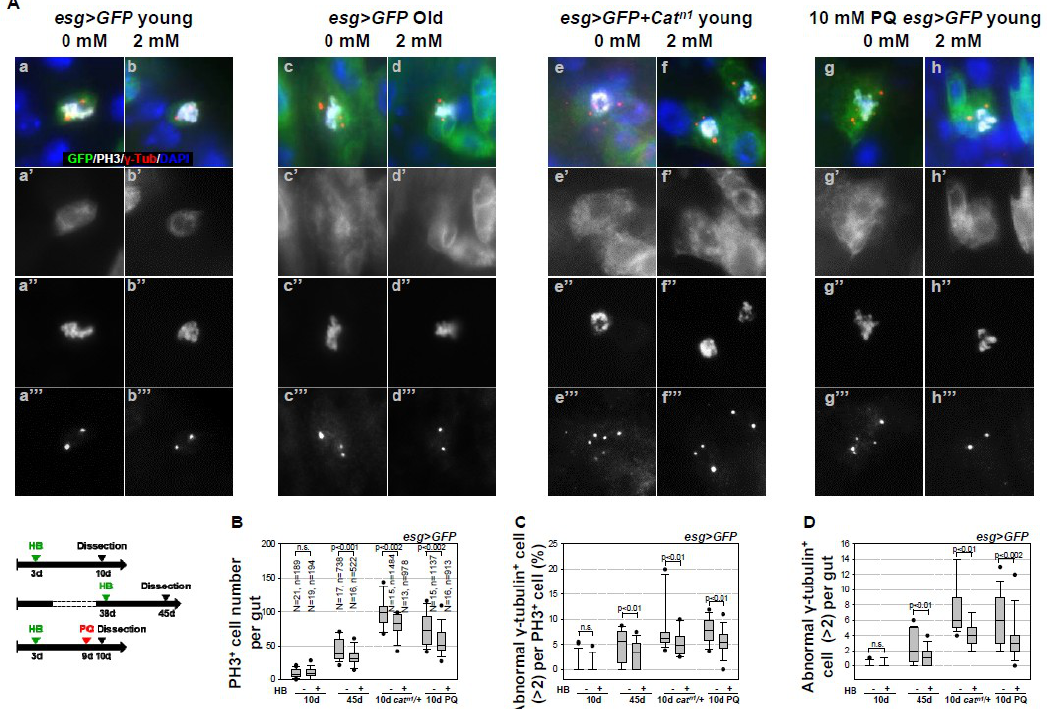
Figure 1. Inhibitory effect of β-HB on age- and oxidative stress-related centrosome amplification in midgut ISCs. ( A ) Guts from 10-day-old esg>GFP flies (a–b”’), 45-day-old esg > GFP flies (c–d”’), and 10-day-old esg > GFP + Cat n1 mutant flies (e–f’”), without (a–a’”, c–c’’’, e–e’’’) or with (b-b’’’, d-d’’’, f-f’’’) 2 mM β-HB feeding for seven days, were stained with anti-γ-tubulin (red), anti-PH3 (white), anti-GFP (green), and DAPI (blue). Ten-day-old esg > GFP flies, without (g–g’”) or with (h–h’”) 2 mM β-HB feeding for six days, were treated with 10 mM PQ in standard media for 20 h, after which their guts were stained with anti-γ-tubulin (red), anti-PH3 (white), anti-GFP (green), and DAPI (blue). a’, b’, c’, d’, e’, f’, g’, and h’ indicate enlarged GFP stained images. a”, b”, c”, d”, e”, f”, g”, and h” indicate enlarged PH3 stained images. a”’, b’”, c’”, d’”, e’”, f’”, g’”, and h’” indicate enlarged γ-tubulin stained images. Original magnification is 400×. ( B ) The number of PH3-positive cells was counted in whole guts from 10-day-old esg > GFP , 45-day-old esg > GFP , 10-day-old esg > GFP + Cat n1 mutant, and 10-day-old PQ-treated esg > GFP flies, with or without β -HB feeding for seven days. N is the number of observed guts, and n is the number of observed PH3-positive cells. n.s. indicates not significant (p > 0.05). ( C ) The frequency of supernumerary centrosomes ( > 2) per mitotic ISC in 10-day-old esg > GFP , 45-day-old esg > GFP , 10-day-old esg > GFP + Cat n1 mutant, and 10-day-old PQ-treated esg > GFP flies, with or without β -HB feeding for seven days. The centrosome numbers were counted in mitotic ISCs (PH3-and GFP-positive cells) in the midgut. n.s. indicates not significant ( p > 0.05). ( D ) The frequency of mitotic ISCs with supernumerary centrosomes per gut in 10-day-old esg > GFP , 45-day-old esg > GFP , 10-day-old esg > GFP + Cat n1 mutant, and 10-day-old PQ-treated esg > GFP flies, with or without β -HB feeding for seven days. The error bar represents standard error. p -values were calculated using Student’s t -test. n.s. indicates not significant ( p >